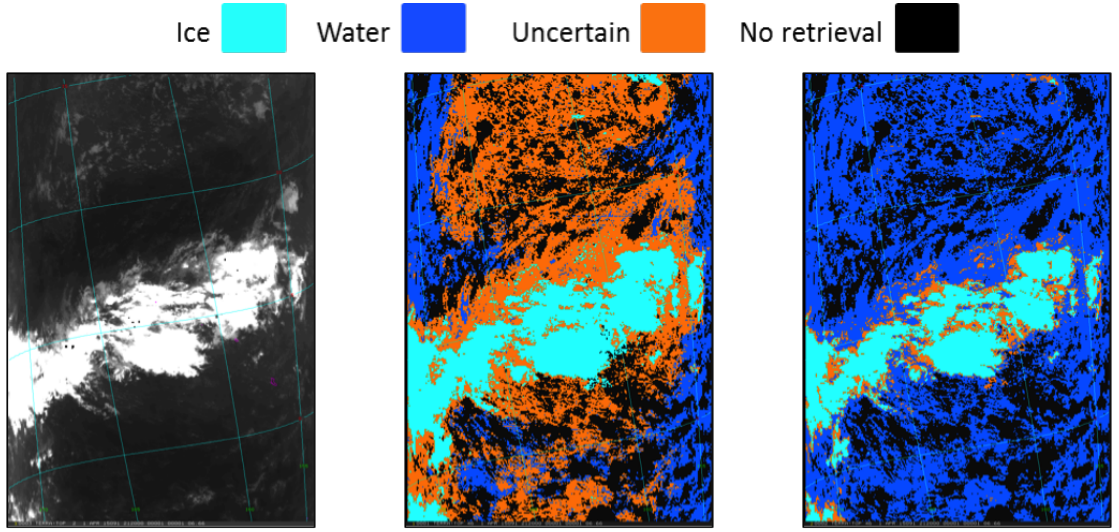
Figure 13. Terra MODIS Band 31 (11 µ m) imagery ( left ) on 1 April 2015, Cloud Particle Phase product before crosstalk correction ( center ) and after crosstalk correction ( right ). Ice particles are indicated by cold (bright) scenes in the 11 µ m imagery. Before crosstalk correction, the CPP data shows abundant mixed phase retrievals (orange) where data scenes are clear or contain water cloud. After crosstalk correction, these scenes are correctly retrieved as either clear or water